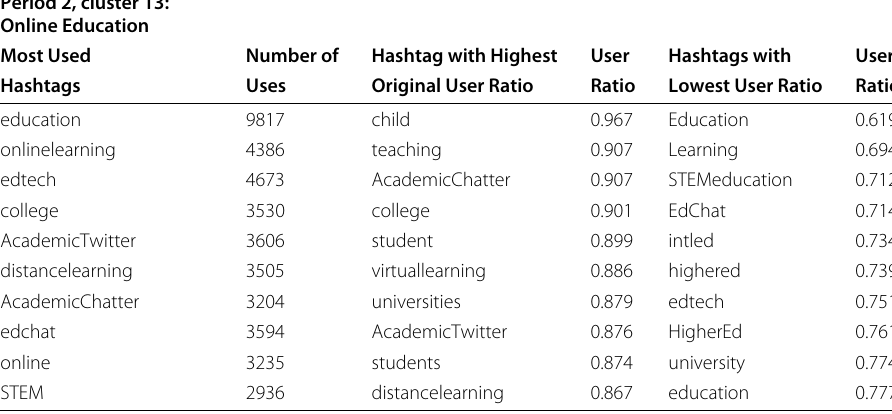
Table 5 Hashtags from period two cluster 12 which focus on online education Period 2, cluster 13: Online Education